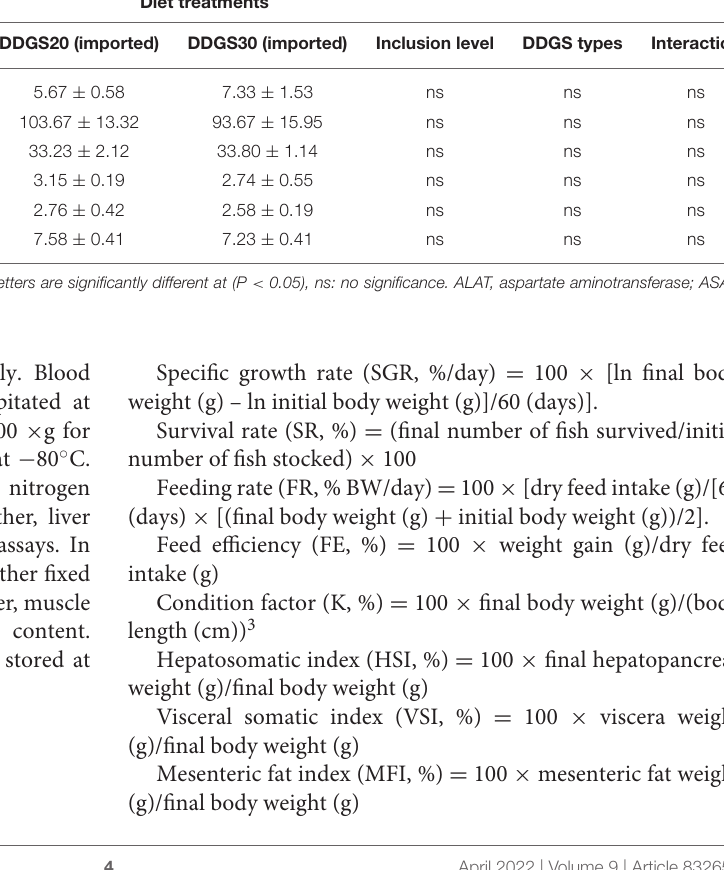
TABLE 5 | The effects of different types and levels of dietary DDGS on serum biochemical a .